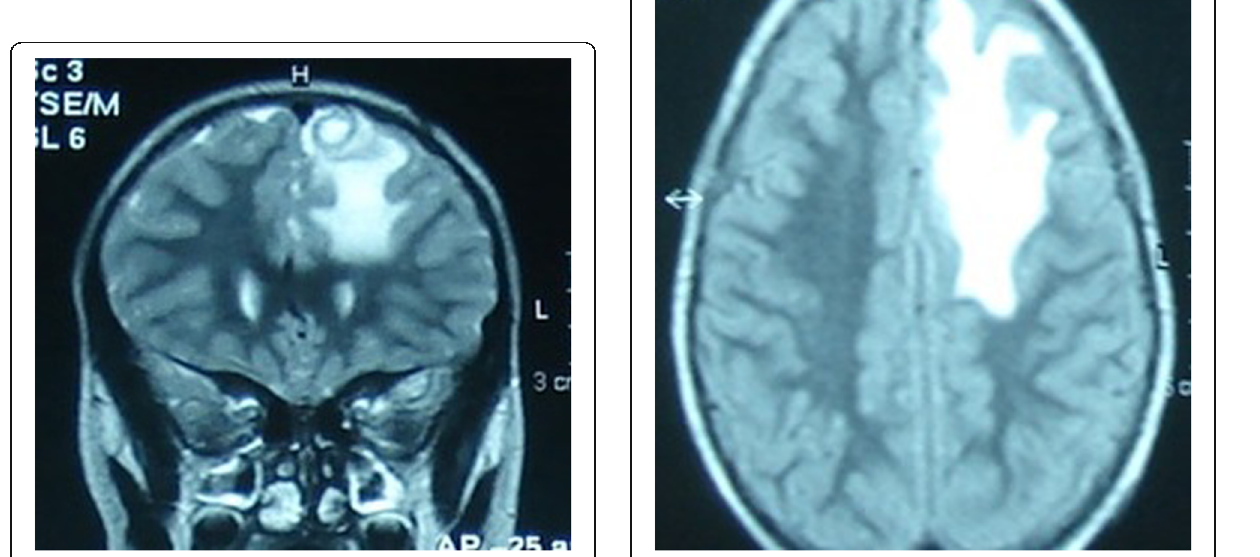
Fig. 4 Axial FLAIR showing perilesional vasogenic oedema that is disproportionate to the size of the